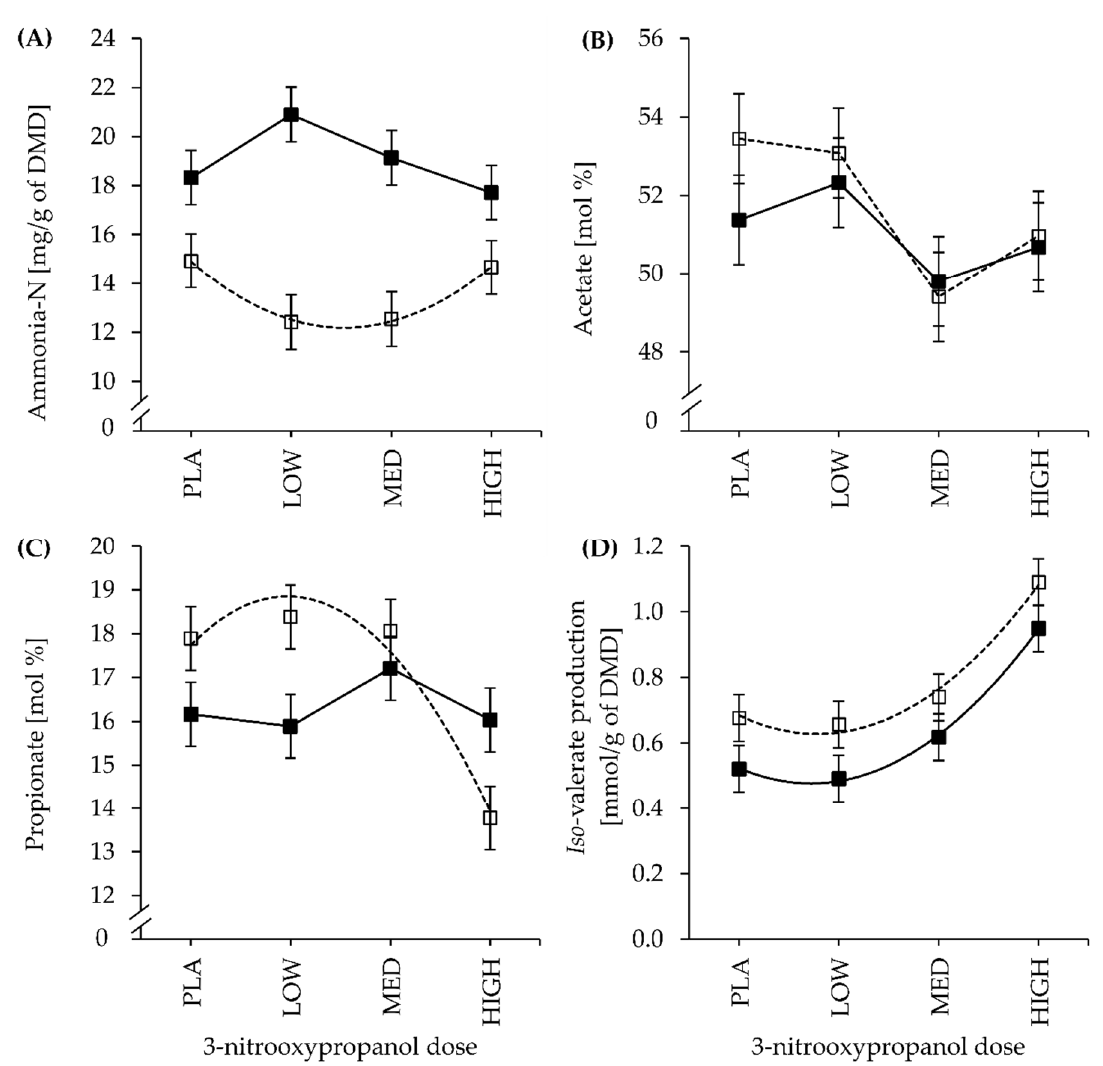
Figure 3. Effect of 3-nitrooxypropanol dose (PLA: 0, LOW: 73, MED: 160, and HIGH: 1200 mg of 3-NOP/kg of feed DM) and low- ( (cid:3) , dashed line) or high- ( (cid:4) , solid line) concentrate proportion in the incubated diet on ( A ) ammonia-N production (mg/g of dry matter degradation (DMD)), ( B ) acetate (mol %), ( C ) propionate (mol %), and ( D ) iso -valerate production (mmol/g of DMD) measured in the effluent; curve fitting according to (non)significant L and Q effects (see Table